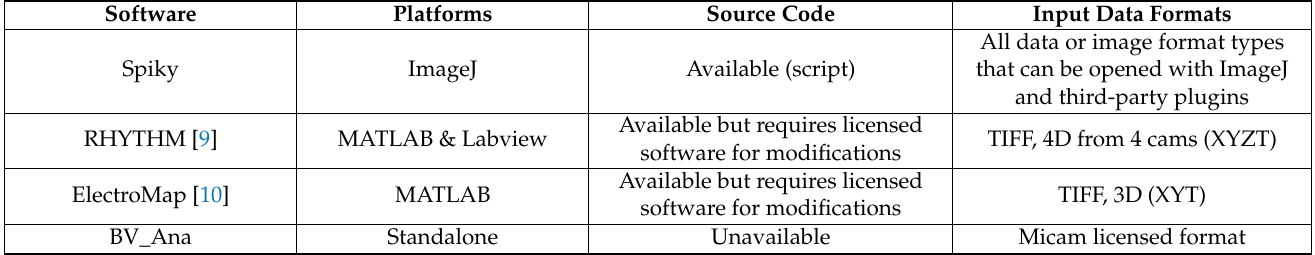
Table 1. Main characteristics of optical mapping analysis